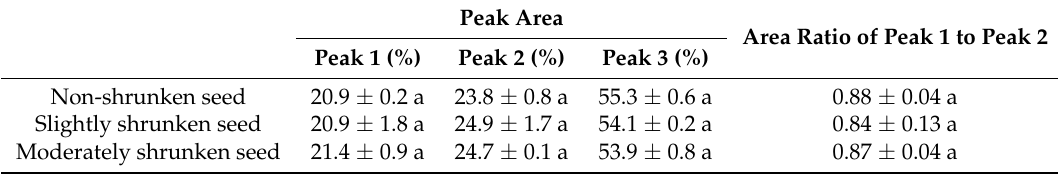
Figure 5. GPC profiles of isoamylase-debranched starches from non-, slightly, and moderately shrunken seeds. Table 1. GPC parameters of isoamylase-debranched starches.